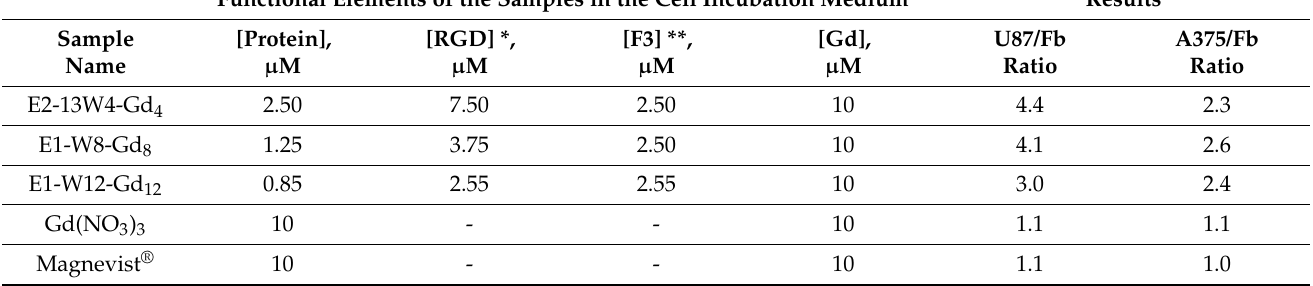
Table 8. Concentrations of the samples and their functional elements during exposure and the Gd accumulation ratio of tumour to normal